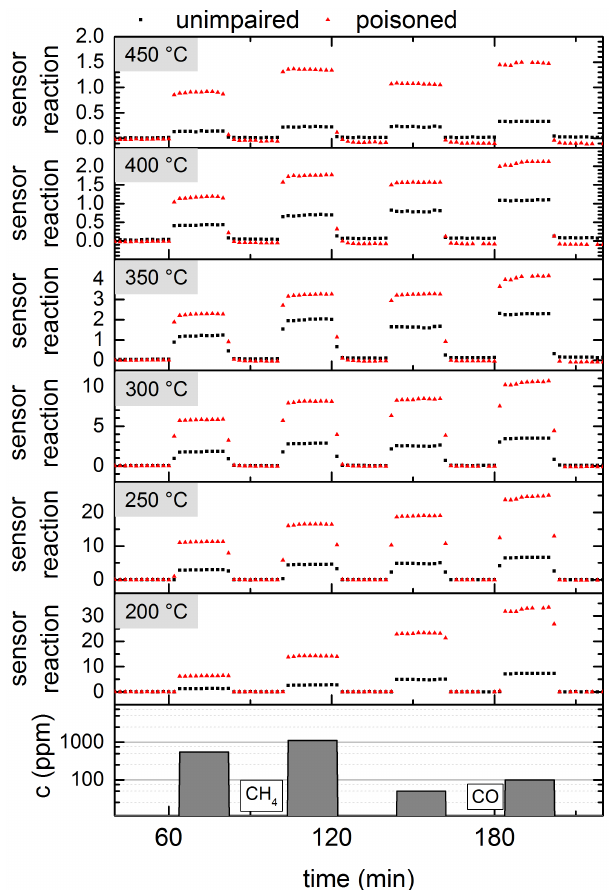
Figure 6. Laboratory measurement, carried out with FoBIS system. The graphs show sensor reactions for each step of the temperature cycle at 61kHz for the unimpaired as well as for the poisoned sen- sor.